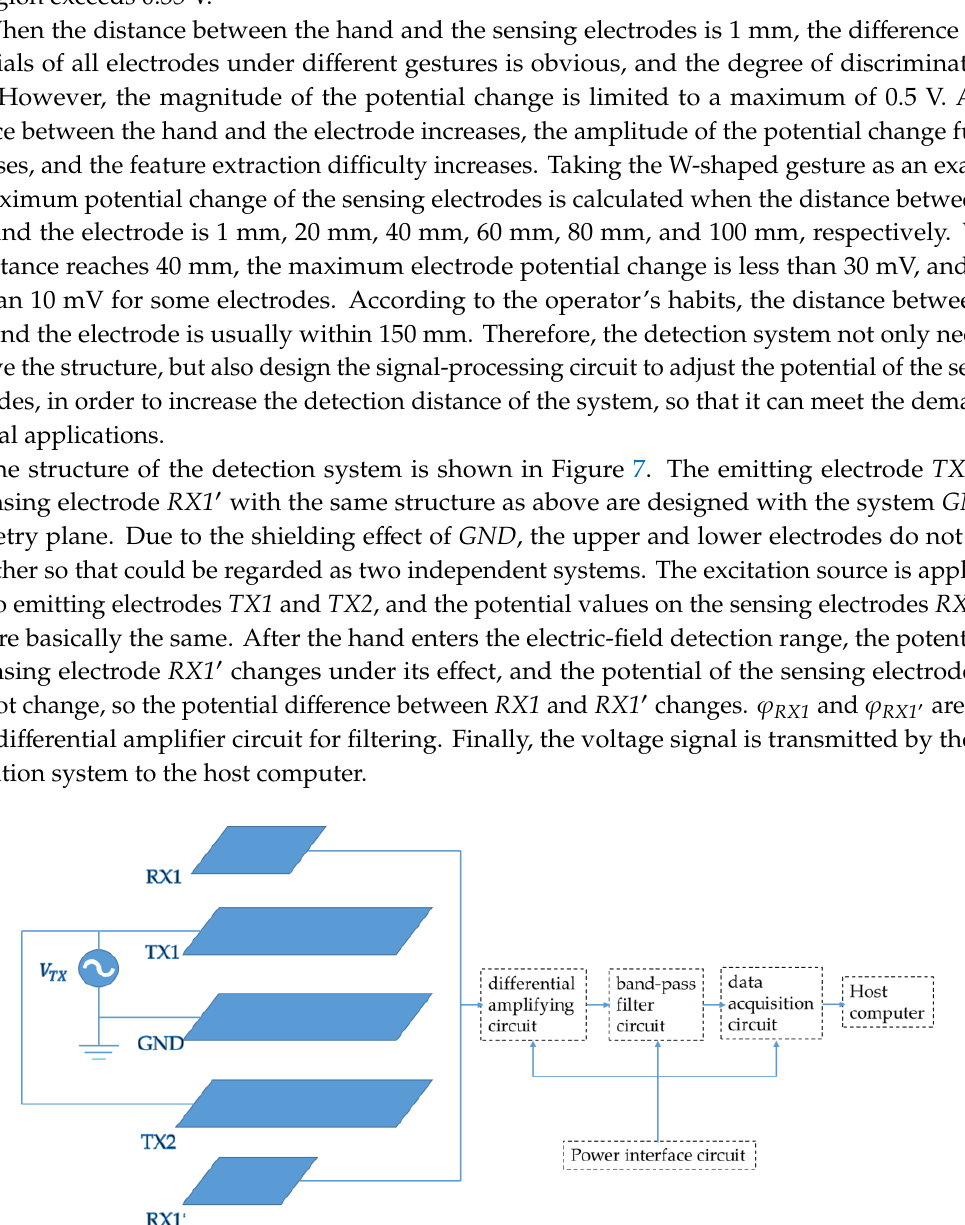
( b ) Figure 8. Detection system which includes detection panel, signal-processing board, data acquisition card: ( a ) The size of various parts of the detection system; ( b ) The location of the various parts of the detection system. Since the sensing electrodes of the detection system have different sizes, the gain of the signal-processing circuit needs to be fine-tuned to ensure that the sensitivities of all electrodes are the same. The metal ball is suspended above the center of the detection panel, and the height of the